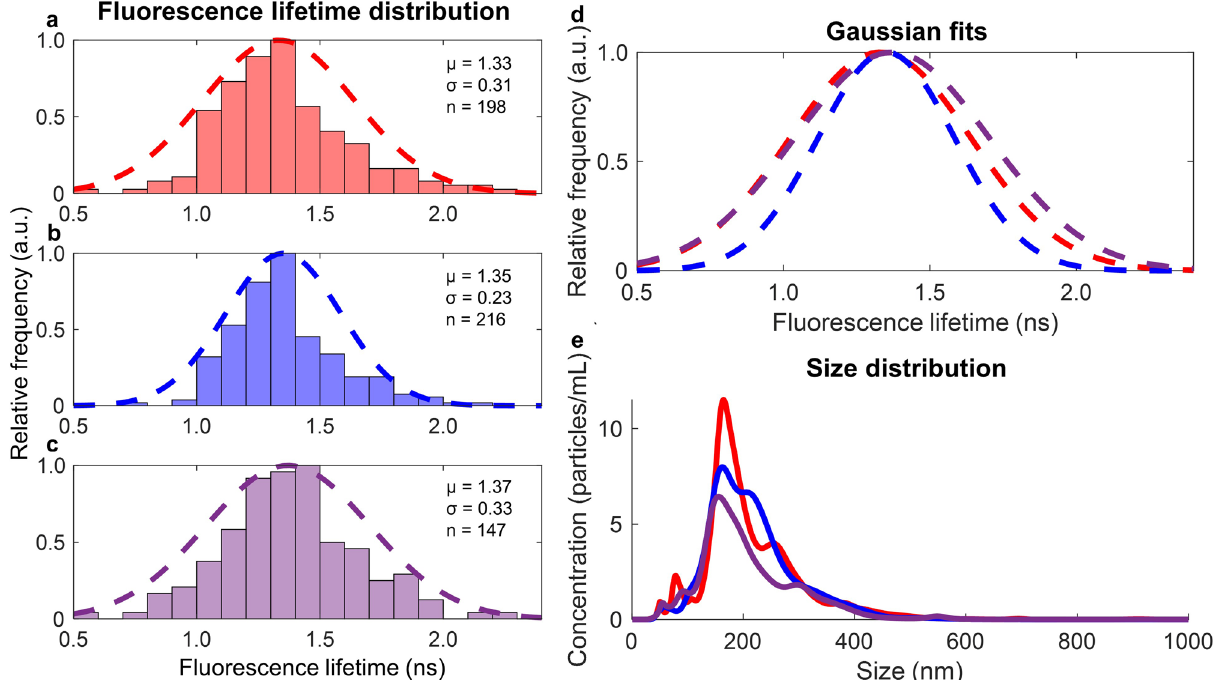
Figure 3. FLIM measurements from three different extracellular vesicle (EV) isolations under similar conditions. ( a – c ) Histograms of the relative number of EVs by fluorescence lifetime and a Gaussian fit ( dashed line ). ( d ) Gaussian fits compared with a Student’s t-test; the three samples are not significantly different with P > 0.05. ( e ) Nanoparticle tracking analysis (NTA) measurements of concentration and size of isolated EVs for the three isolations. Concentration is calculated to correspond to EVs per mL of cell culture fluid in T175 cell culture flasks with 30 mL of media per flask. First replicate is indicated in red, second in blue, and third in